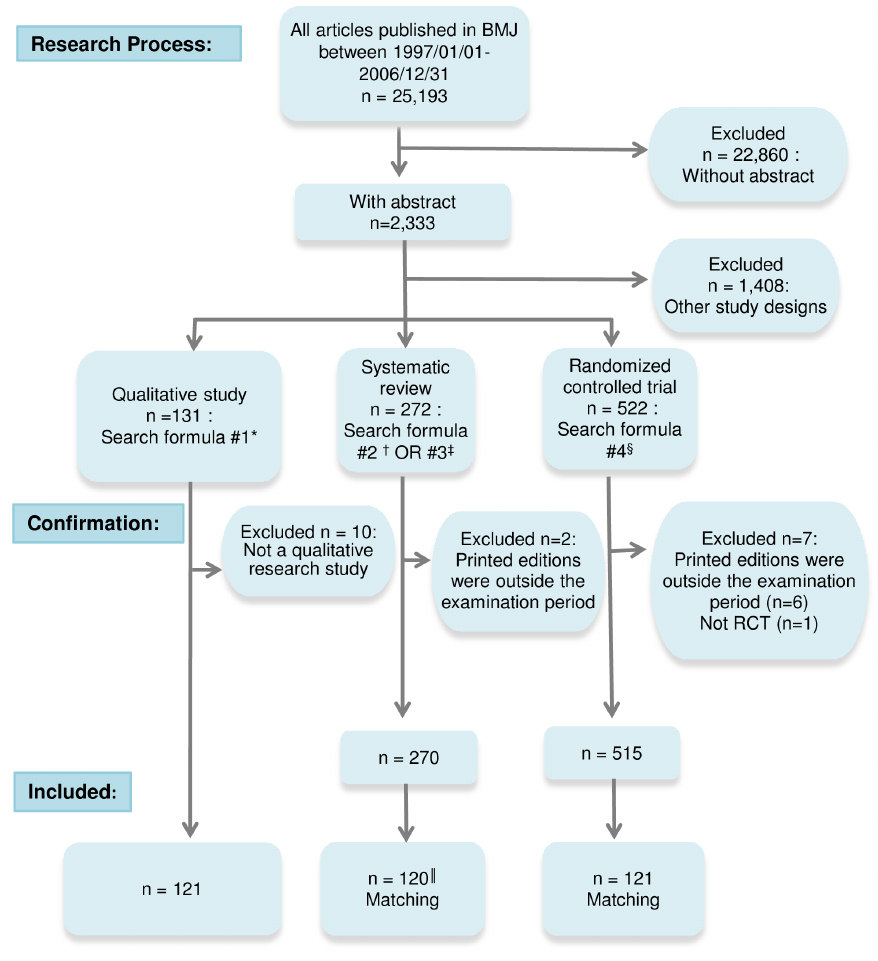
Figure 1. Selection procedure for studies surveyed in each study design. *Search formula # 1: "BMJ[jour] AND (qualitative AND (research OR study); Limits: only items with abstracts, Publication Date from 1997/1/1 to 2006/12/31". { Search formula # 2: "BMJ[jour] Limits: Meta-Analysis Limits: only items with abstracts, Publication Date from 1997/1/1 to 2006/12/31". { Search formula # 3: "BMJ[jour] AND ("systematic review"[ti]) Limits: only items with abstracts, Publication Date from 1997/1/1 to 2006/12/31". 1 Search formula # 4: "BMJ Limits: only items with abstracts, Randomized Controlled Trial, Publication Date from 1997/1/1 to 2006/12/31". ||Although we identified 15 qualitative studies in 2001, we only confirmed 14 systematic reviews in that year. Therefore, the sum of cited documents for this type of publication was 120.